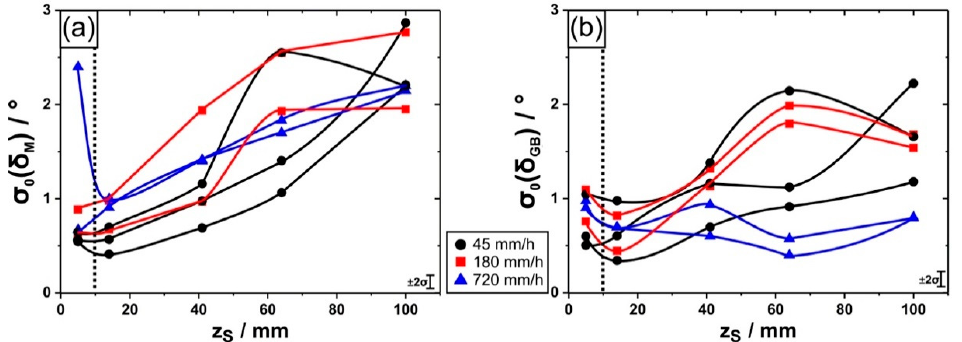
Figure 9. Evolution of scattering in dendrite orientations for seven different SX ingots along their longitudinal axes. ( a ) Standard deviation of dendrite growth direction angles δ M . ( b ) Standard deviation of angles between adjacent dendrites δ GB . The dashed vertical lines indicate the transition zone between seeds and newly grown crystals.